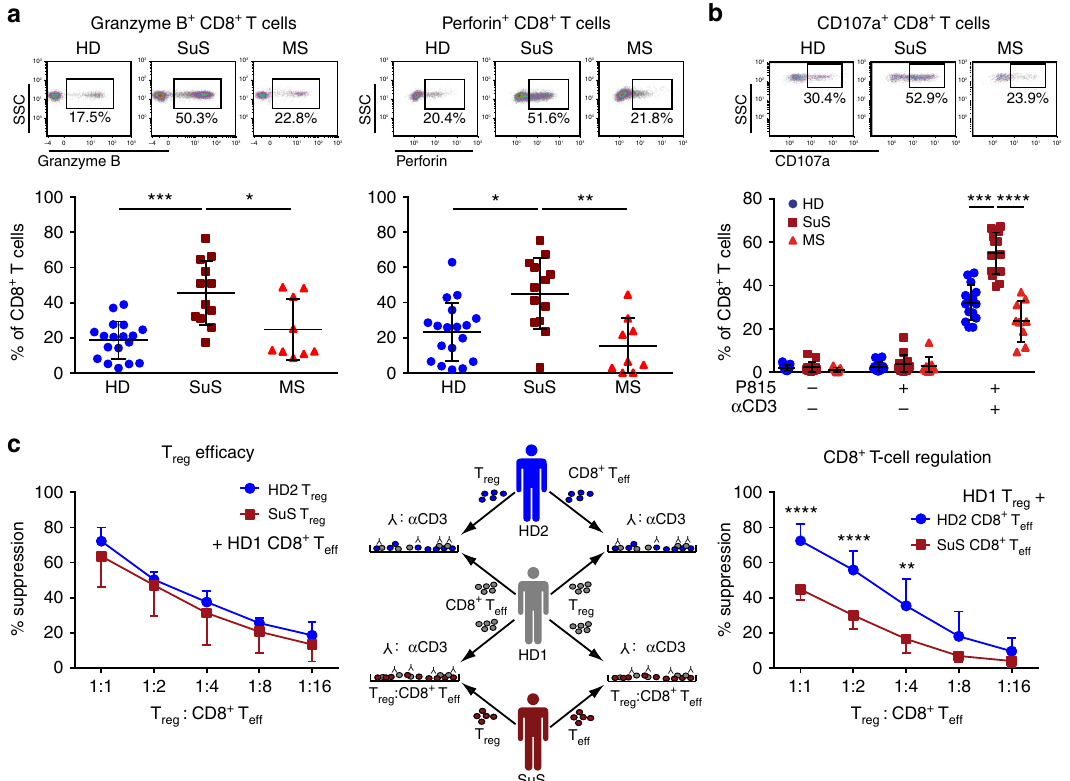
Fig. 3 CTLs are more prevalent in the periphery of SuS patients. a Representative examples (top) and quanti fi cation (bottom) of granzyme B (GrB; left) and perforin (right) expressing CD8 + T cells circulating in the blood of HD (closed blue circles, n = 18), SuS patients (closed cayenne squares, n = 13), and MS patients (closed red triangles up, n = 9). b Representative examples (top) and quanti fi cation (bottom) of CD107a-expressing CD8 + T cells from HD (closed blue circles, n = 15), SuS patients (closed cayenne squares, n = 14), and MS patients (closed red triangles up, n = 9) under the indicated conditions of re-directed lysis assay with α CD3-linked P815 cells. c Middle: Experimental set-up of allogenic suppression assays to test the suppressive capacity of regulatory T cells. Left: Graphs representing the degree of suppression of proliferation of HD CD8 + T cells upon co-culture with titrated numbers of T reg from HD (closed blue circles) and SuS (closed cayenne squares) ( n = 3). Right: Graphs representing the degree of suppression of HD (closed blue circles, n = 7) and SuS patient (closed cayenne squares, n = 7) CD8 + T cell proliferation upon co-culture with titrated numbers of independent HD T reg . Statistical analysis was performed using Kruskal – Wallis test with Dunn ’ s post-test ( a , b ) or two-way ANOVA with Bonferroni post-test ( c ), respectively. Error bars indicate the mean ± s.d.; p values: * p < 0.05; ** p < 0.01; *** p < 0.001; **** p < 0.0001. Source data are provided as a Source Data fi